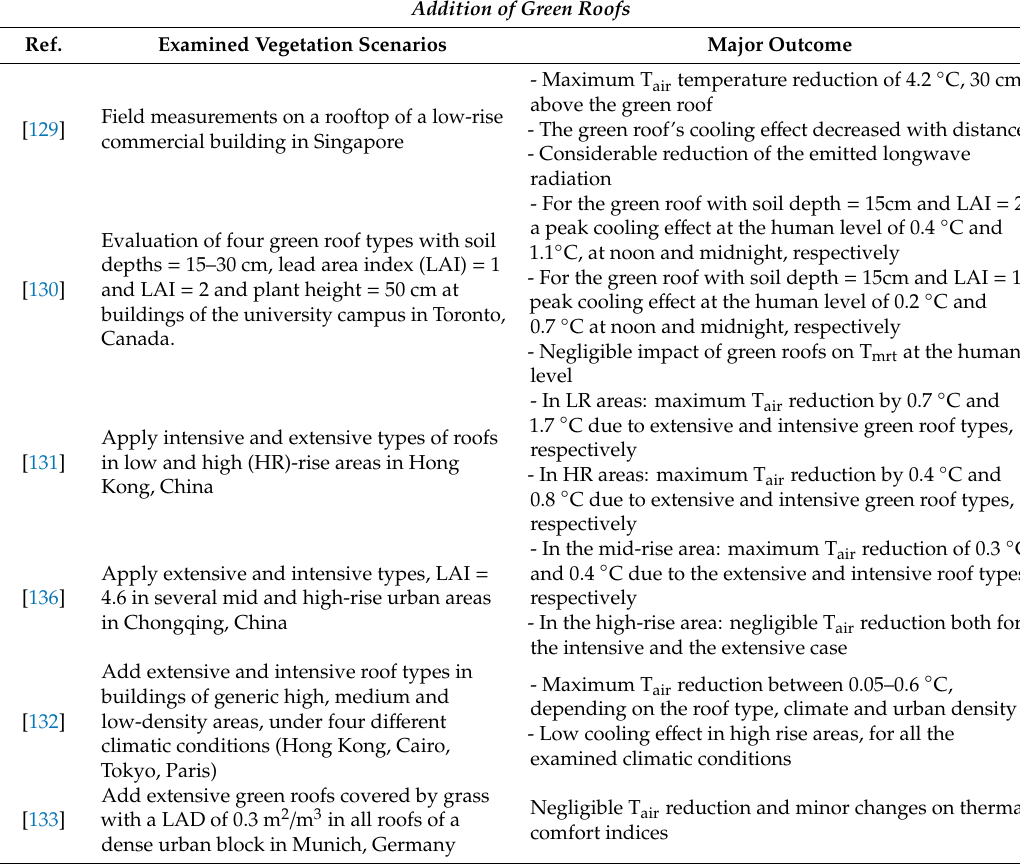
Table 3. Summary of previous studies, assessing the cooling potential of green roofs. T air and T mrt simulation results refer to the pedestrians’ heights (i.e., 1.5–2.0m from the ground